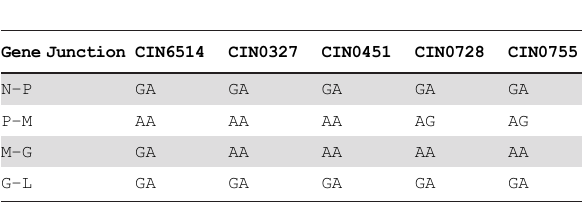
Table 2. Intergenic dinucleotide for all the gene junctions (3 9 R 5 9 direction) in CHPV whole genome